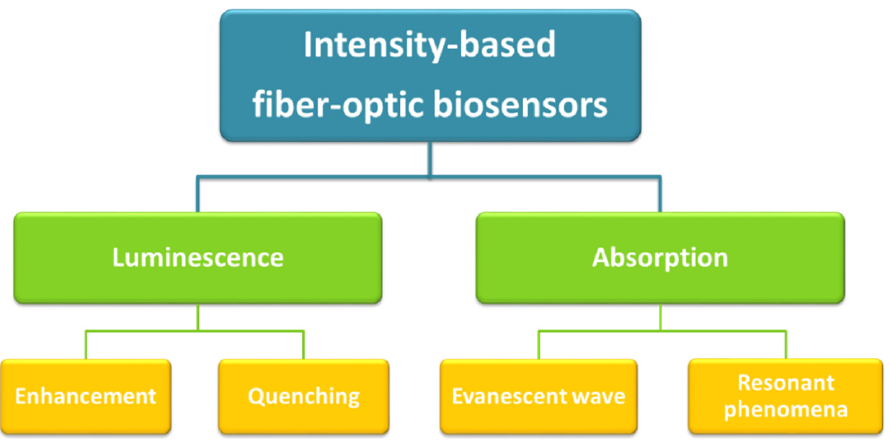
Figure 1. Schematic of the intensity-based optical fiber biosensors analyzed in this review. A common characteristic to every biosensor based on these techniques is the fact of working with multimode fibers. The first reason to justify this is that intensity-based sensors usually need a higher light intensity than phase modulated sensors [20]. In this sense, multimode fibers allow transporting high intensities along their thicker core. Moreover, it is possible to increase the light coupling by manufacturing different geometries on the optical fiber. The most representative ones are described throughout this